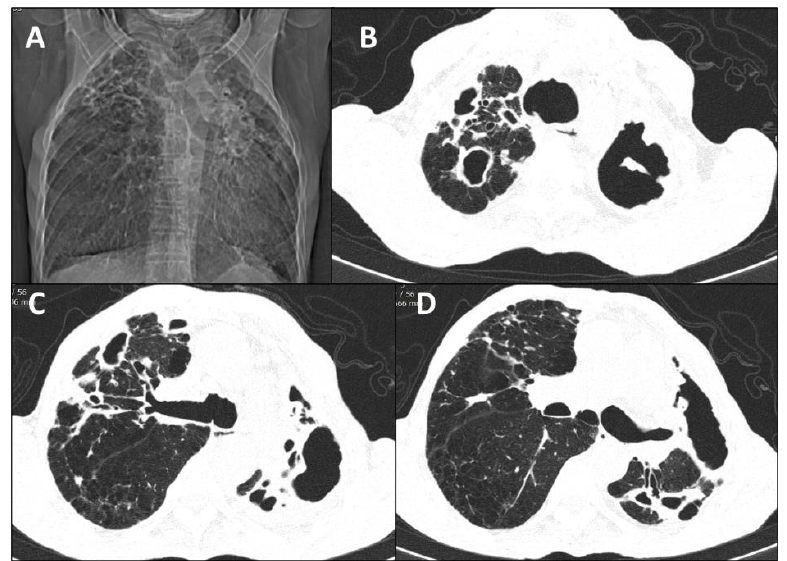
Figure 1. Primary pulmonary sporotrichosis in a 71-year-old man (Case 1). ( A ) Topogram depicts lung cavitary lesions. ( B – D ) Axial nonenhanced chest computed tomography images show extensive thick-walled cavities with irregular margins in upper lobes. The cavitary lesion is more predominant in the left upper lobe, associated with thick septations and pulmonary volume loss.